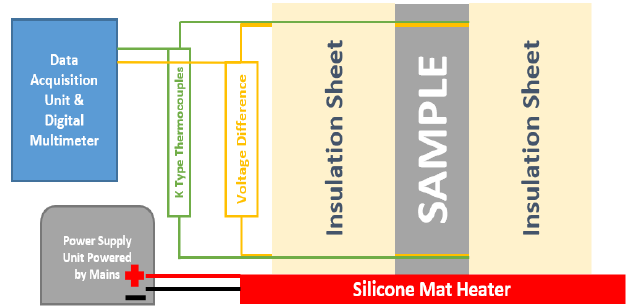
Figure 1. Experimental setup for Seebeck coefficient measurement.